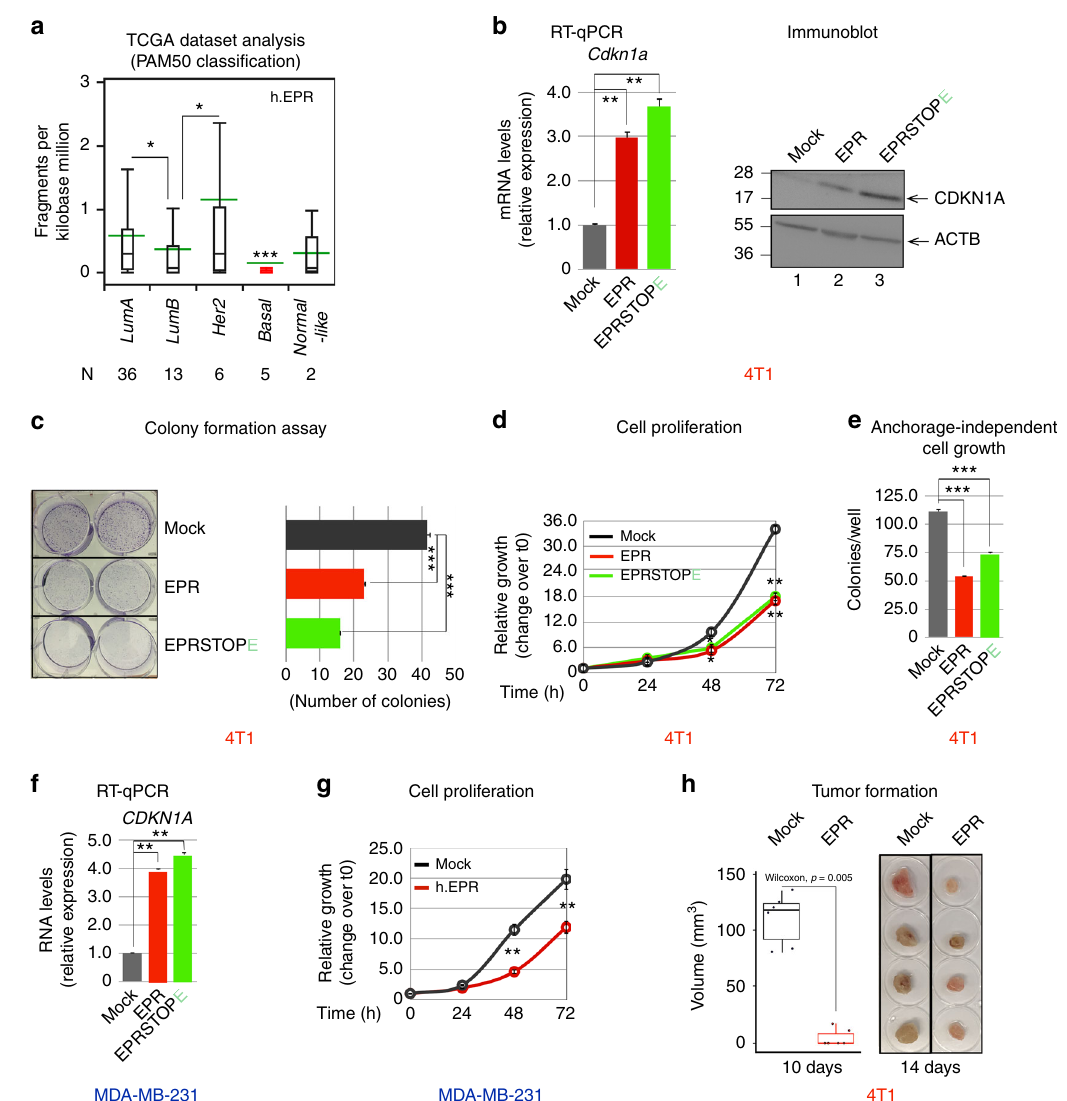
Fig. 6 Antiproliferative effect of EPR when expressed in transformed mammary gland cells. a Box plot shows the expression of h.EPR in the TCGA Breast Cancer (BRCA) dataset annotated according to PAM50 molecular subtype classi fi cation. The number of samples in each subtype is presented.